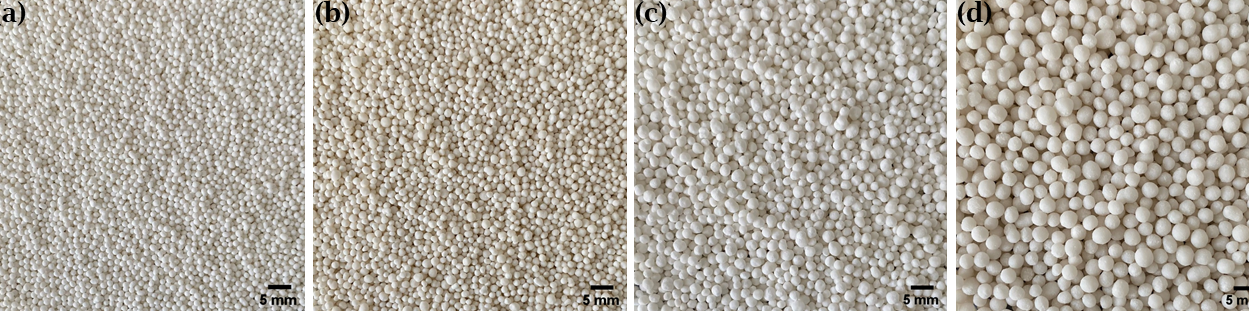
Figure 10. Pellets of the multi-step manufacturing process. ( a ) Lac 400:MCC 101 ratio 60:40, ω wet 31.9%. ( b ) Lac DCL 21:MCC 101 ratio 60:40, ω wet 28.8%. ( c ) Man 50 C:MCC 101 ratio 60:40, ω wet 31.5%. ( d ) Paracetamol:Lac 200:MCC 101 ratio 40:40:20, ω wet